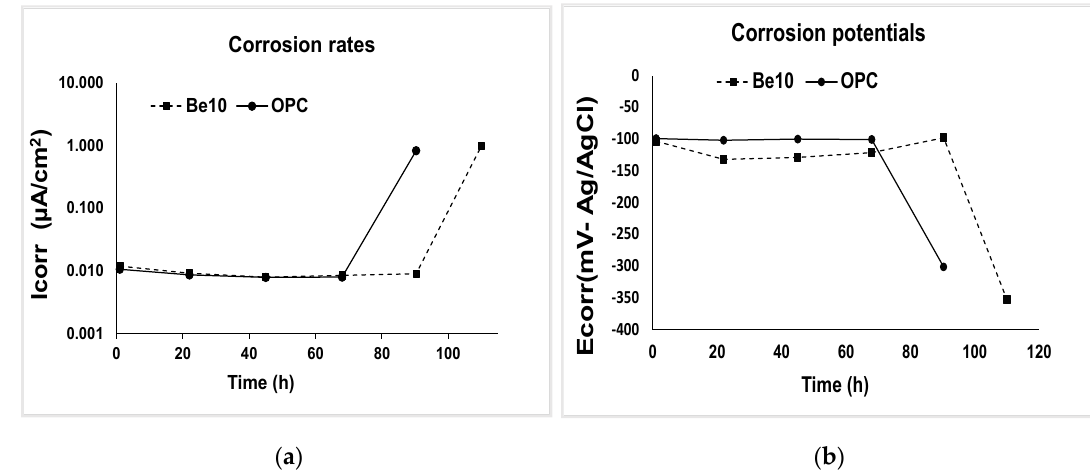
Figure 9. ( a ) Corrosion potential (0 to 100 h) and ( b ) corrosion rate (0 to 120 h), illustrating the abrupt change in tendency that denotes the onset of reinforcement depassivation.